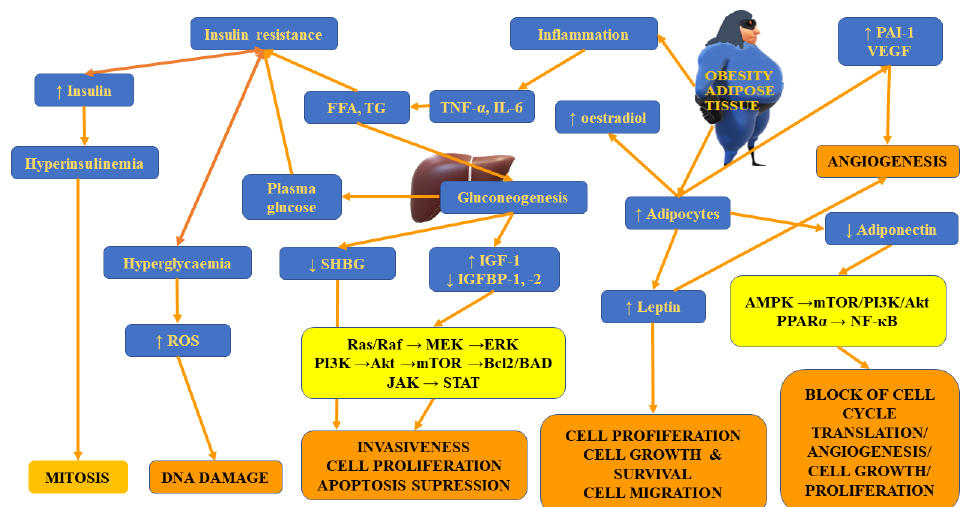
Figure 3. The summary of insulin-resistance- and adipose-tissue-related mechanisms involved in tumour initiation, progression and metastases .